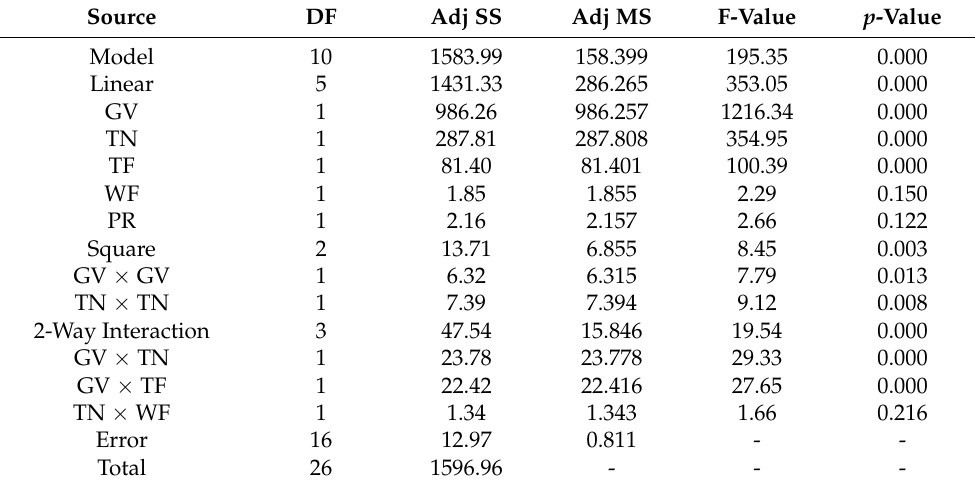
Table 8. ANOVA for VRR.